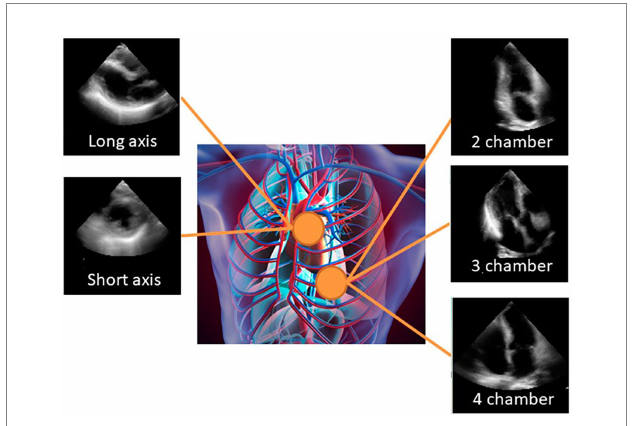
FIGURE 3 Sample of typical cardiac views: apical 2-chamber, apical 4-chamber, apical 3-chamber, parasternal long axis (PLAX), and parasternal short axis [PSAX; image from